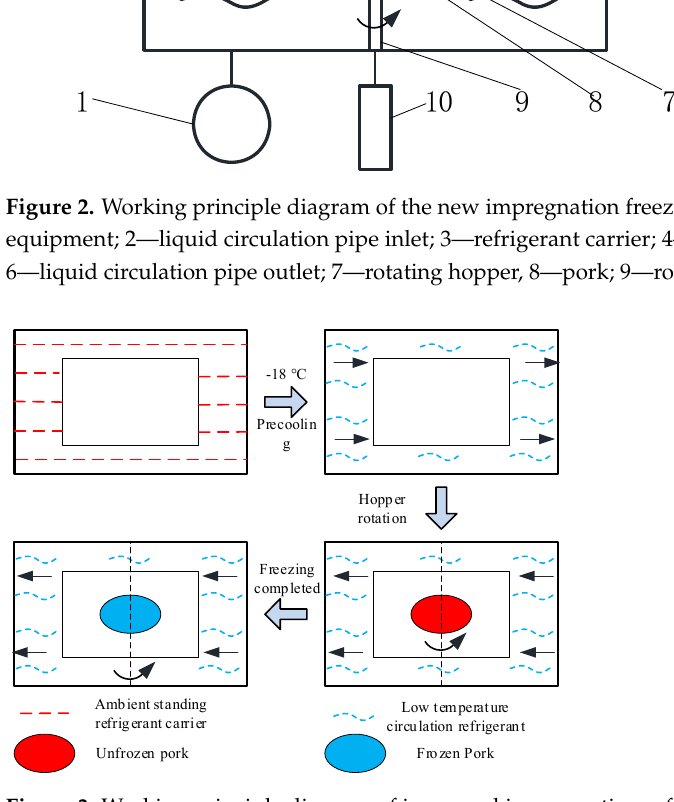
Figure 2. Working principle diagram of the new impregnation freezing equipment. 1—refrigeration equipment; 2—liquid circulation pipe inlet; 3—refrigerant carrier; 4—display; 5—circulation pump; 6—